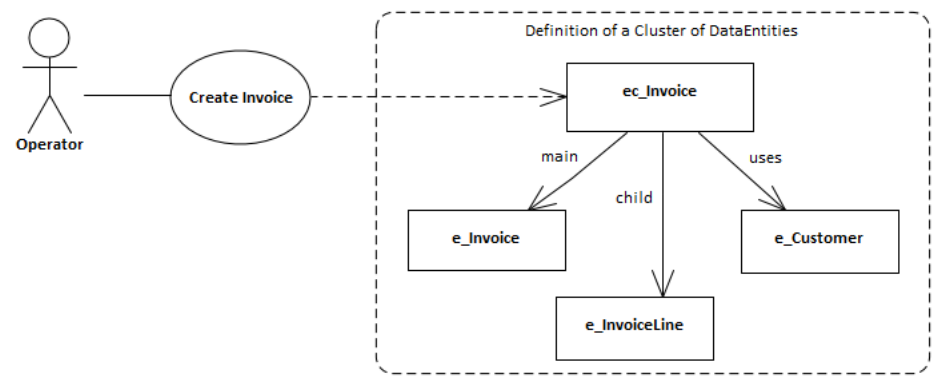
Figure 6. A cluster of data entities used in the scope of a use case (UML-based notation).